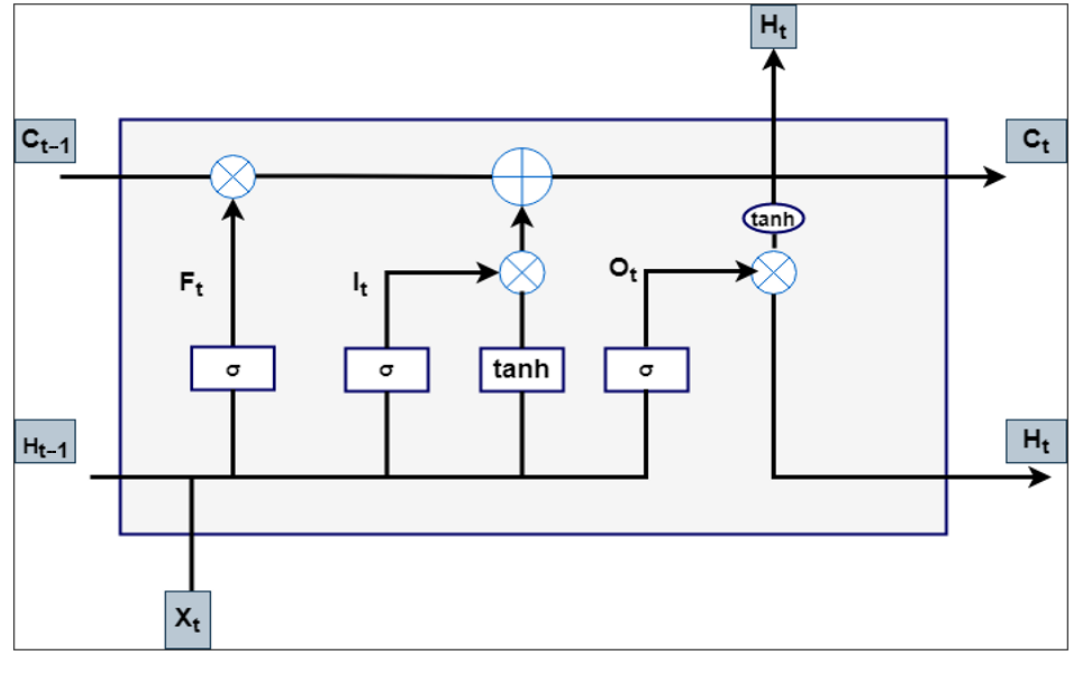
Figure 5. The architecture of LSTM cell.